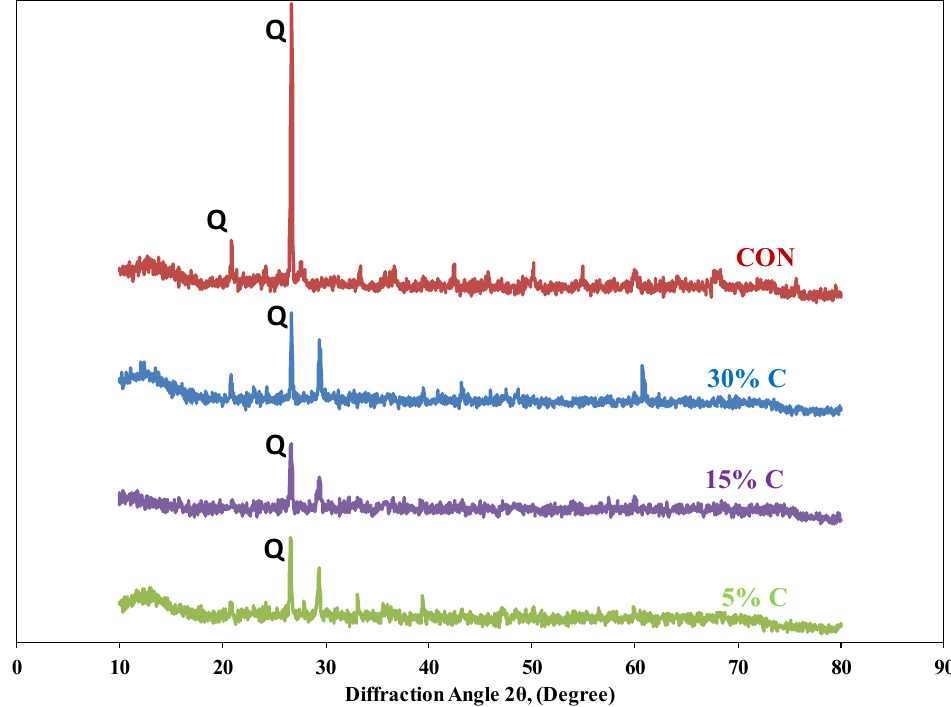
Figure 17. XRD of the brick specimens with different percentages of cement. (CON represents the